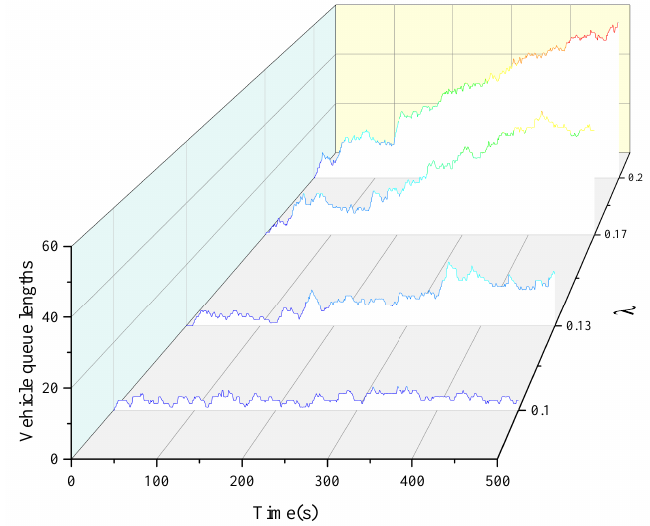
Figure 11. Numbers of vehicles queued at the intersection (queue lengths) when the VARs are 0.1, 0.13, 0.17, and 0.2.